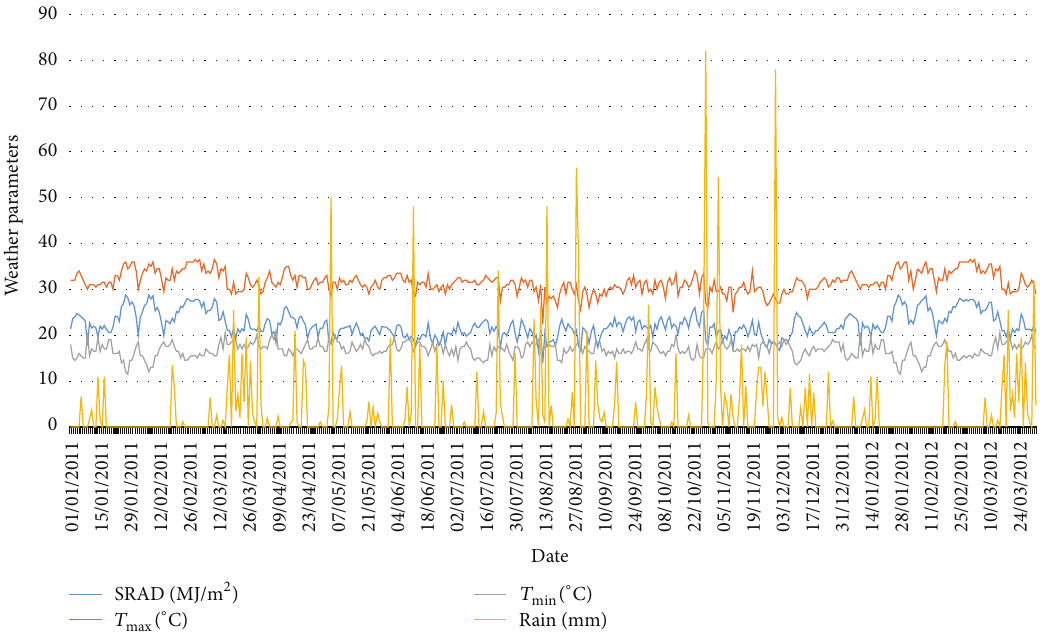
Figure 2: Ahero weather for